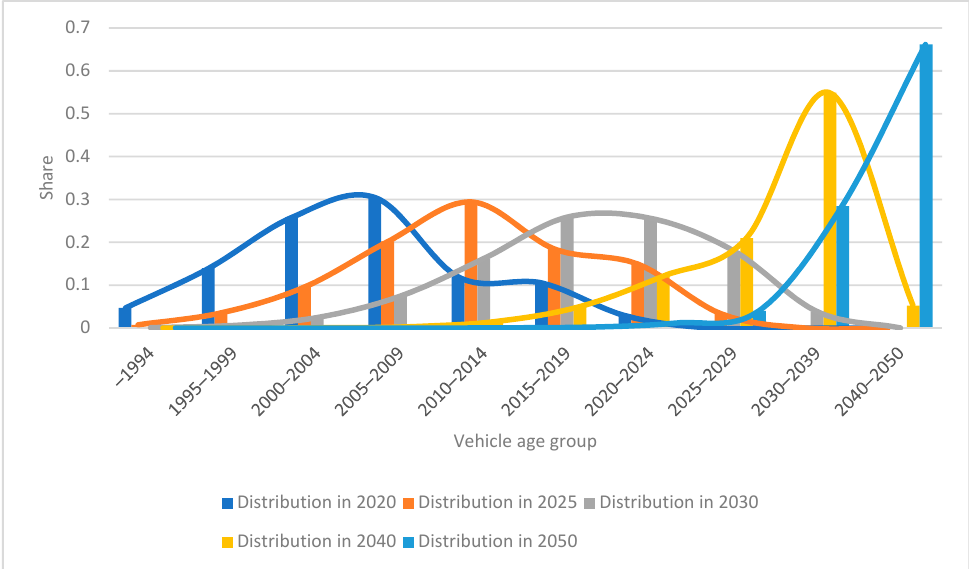
Figure 4. Vehicle age distributions by vehicle age groups for each modeling year.